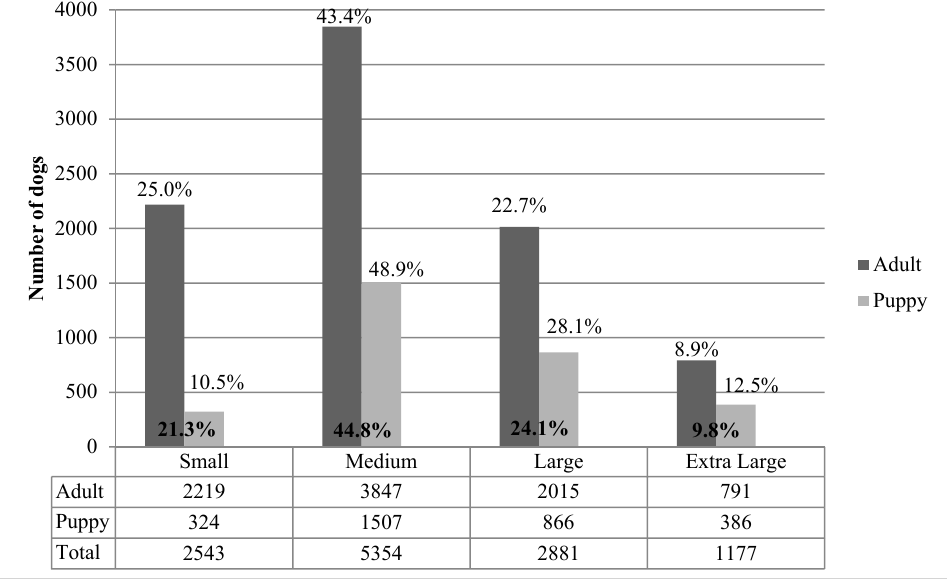
Figure 2. Estimated adult size (dog size was defined as follows: small dogs are less than average knee height, medium dogs are approximately knee height, large dogs are approximately thigh height and extra large dogs are hip height or taller) of 11,955 dogs admitted to RSPCA-QLD shelters in 2014 (12 dogs were excluded from the analysis because estimated mature size was not recorded).